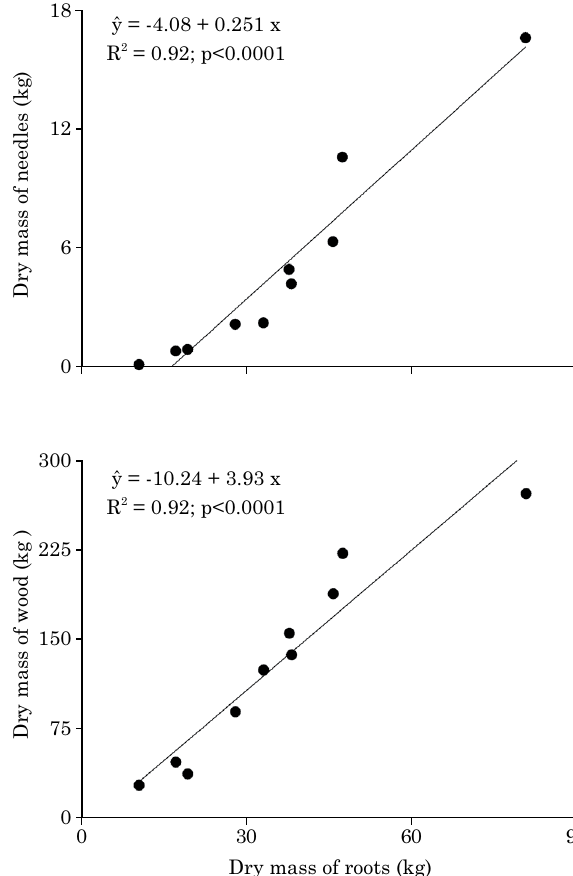
figure 3. relationship between dry mass of roots and dry mass of needles (a) and wood (b) collected in otacílio costa, Sc,